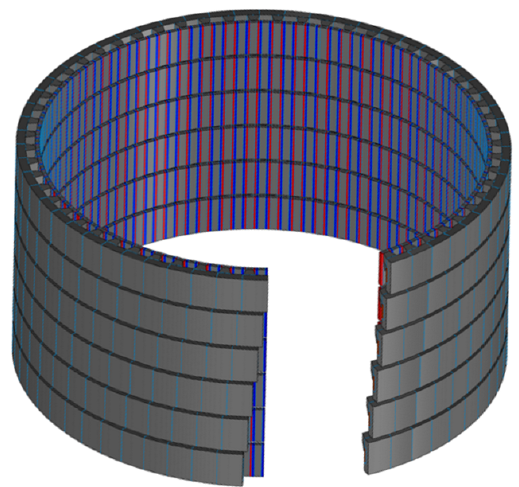
Figure 3: Six-phase claw pole TFPM